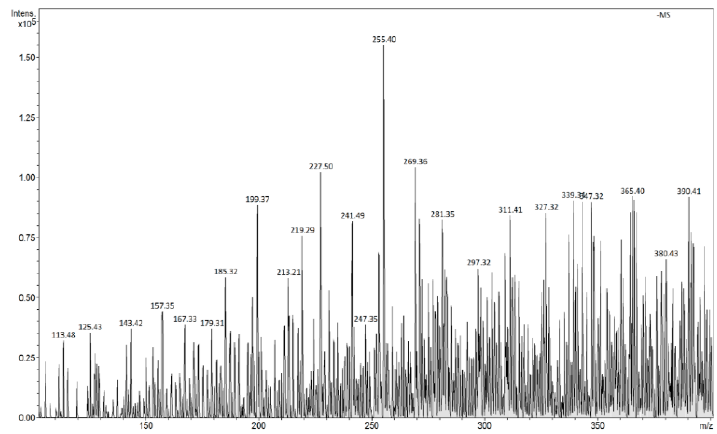
Figure 6. FAPA-MS spectrum of MIP in the range of negative ions.